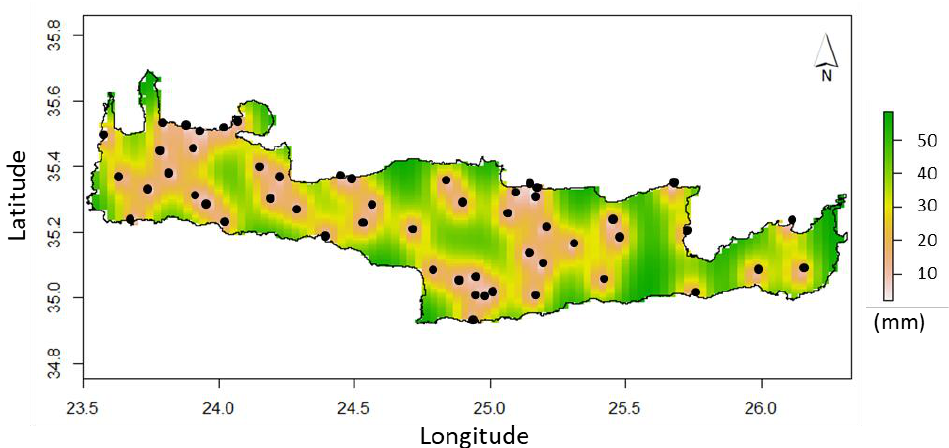
Figure 7. Spatial distribution of the estimated uncertainty using STRK and the sum-metric space–time variogram model for the year 2016/17.